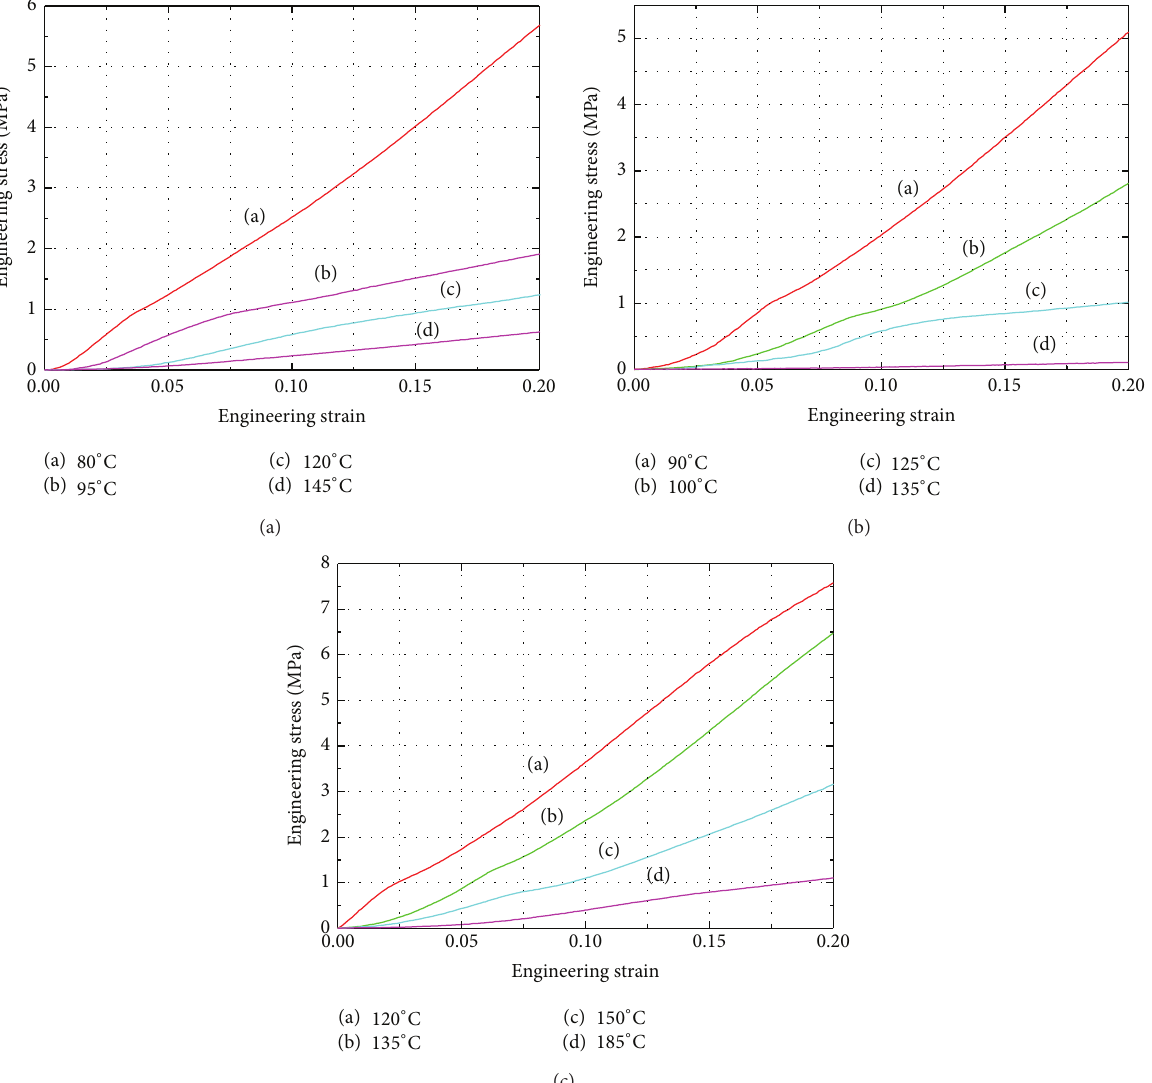
Figure 5: Stress-strain curves of (a) PMMA, (b) PS, and (c) PC at different temperatures with a constant strain state of 0.9𝐸 − 3 s −1 .